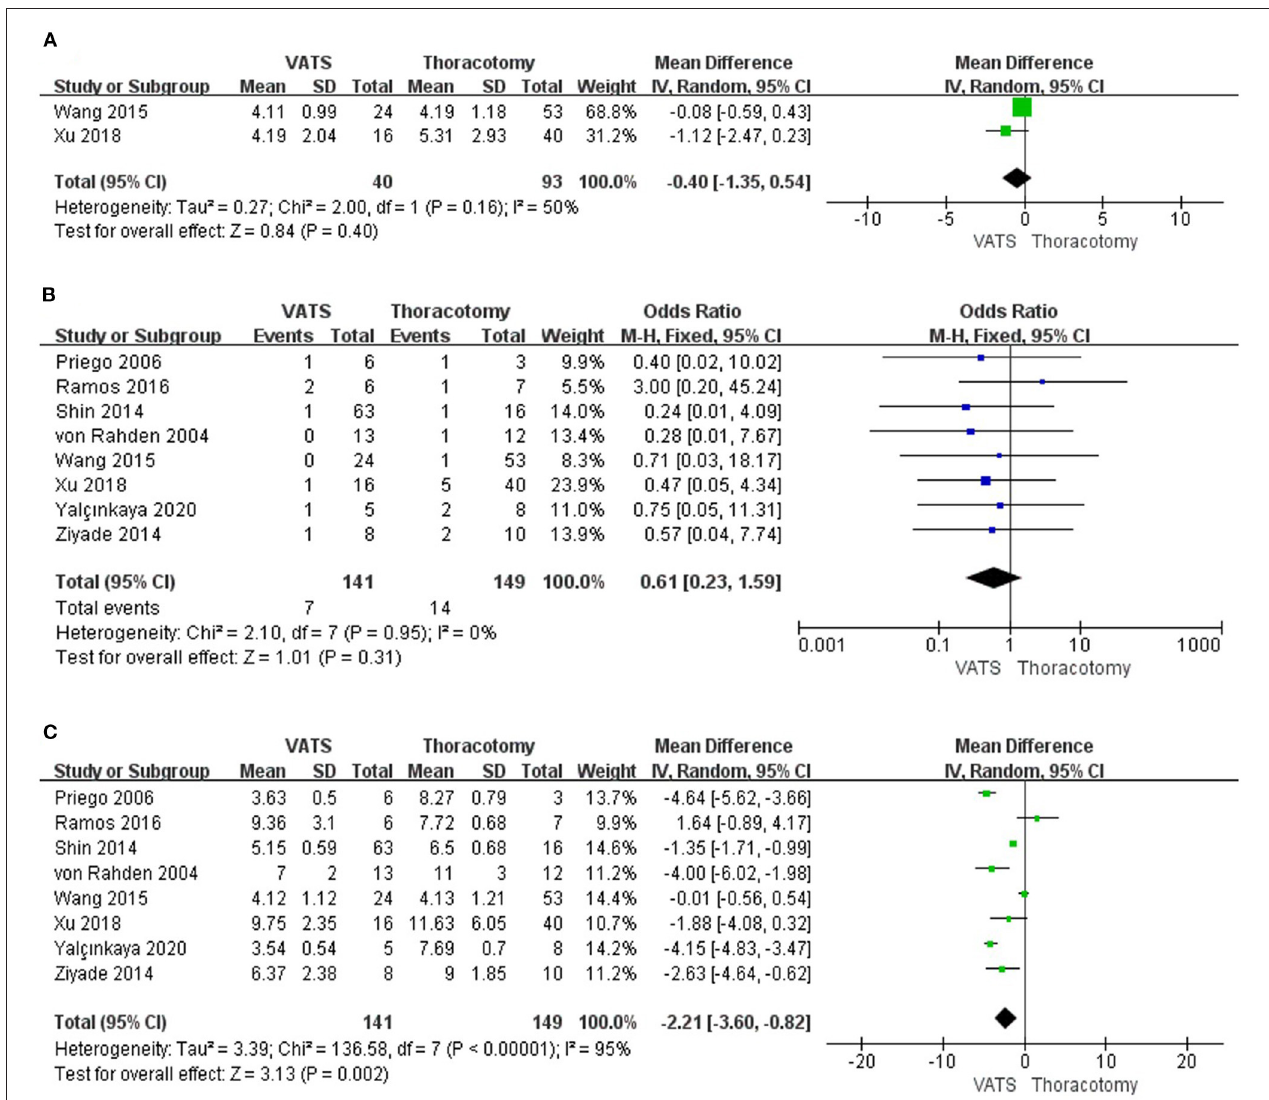
FIGURE 3 | Forest plot of the meta-analysis. (A) Postoperative pleural drainage days. (B) Postoperative complications. (C) Length of postoperative hospital